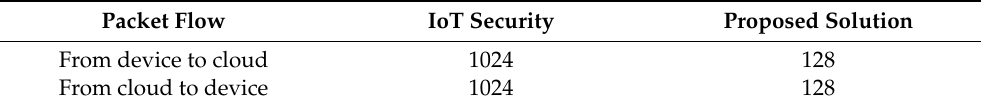
Table 3. Packet overhead (bytes) with recent